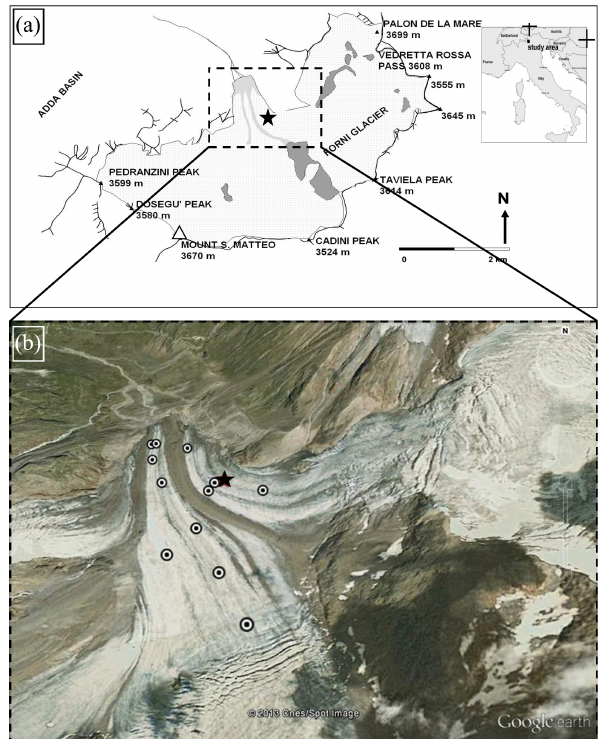
Figure 1. (a) The position of Forni Glacier in the Italian Alps and of AWS1 Forni (black star, in both panels). (b) Enlarged view of the Forni Glacier (image credit: GoogleEarth TM ), showing the location of field measurements (black dots).